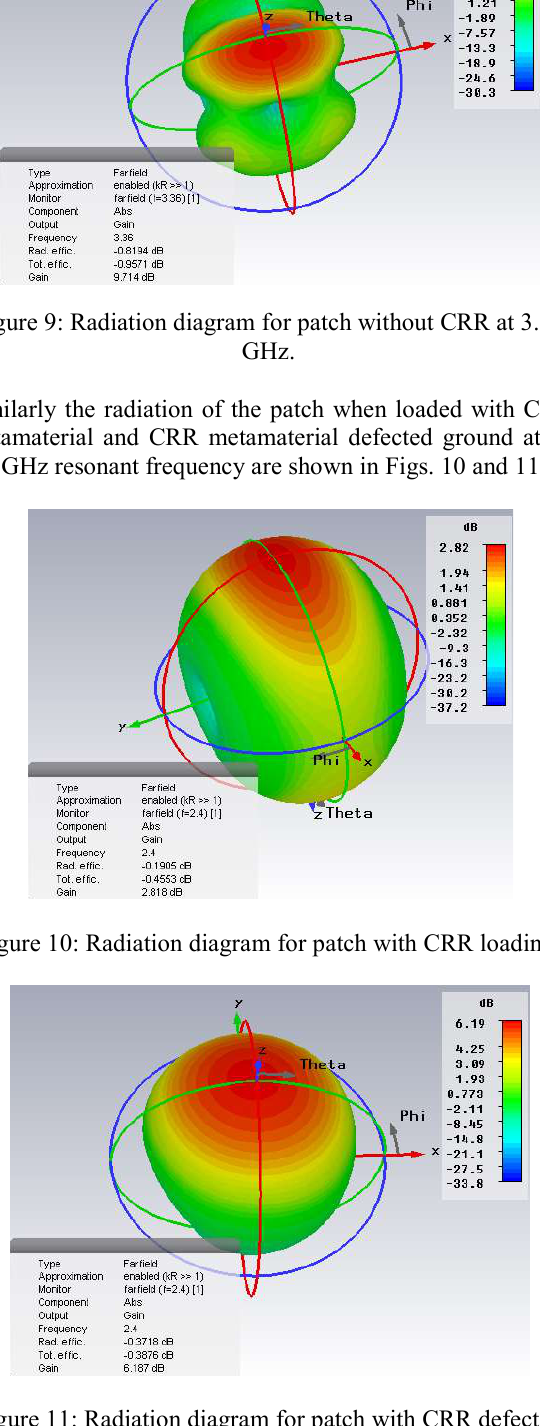
Figure 11: Radiation diagram for patch with CRR defected ground